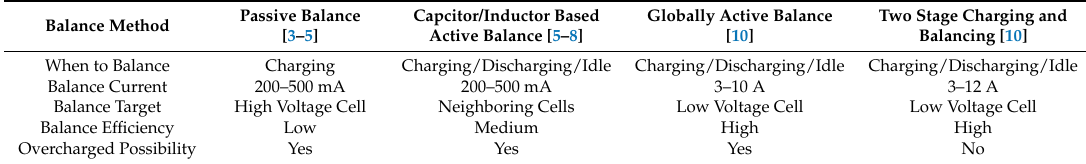
Table 1. Comparison of various balance methods.